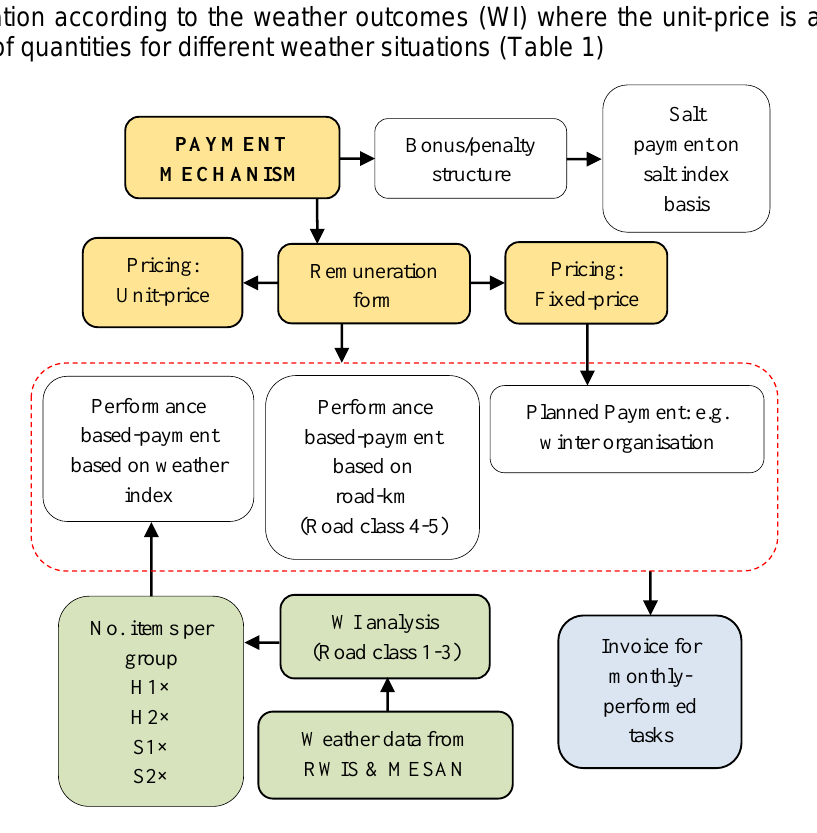
Figure 2 Flow chart of the Swedish payment mechanism for winter road